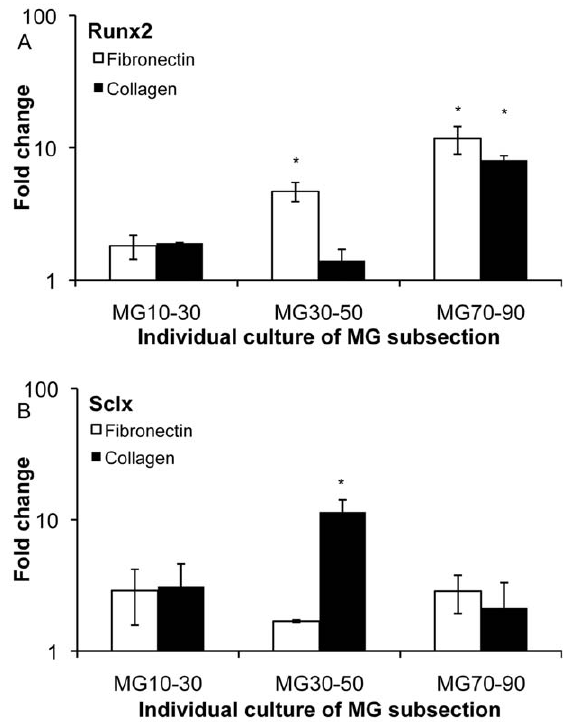
Figure 5. Molecular assessment similar to staining experi- ments. PCR assessed the expression of (A) Runx2 factor and (B) scleraxis, which was expressed with trends consistent with the staining data. * statistical difference (p , 0.05) compared to MG10–30 culture condition.